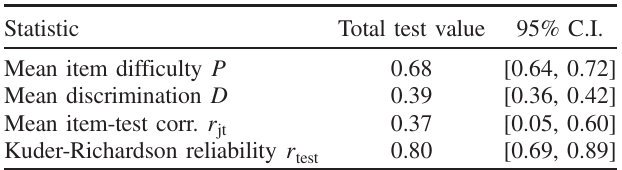
TABLE VI. KiRC pretest statistics obtained from the replica- tion sample in winter term 2016/2017 ( N ¼ 38 ).